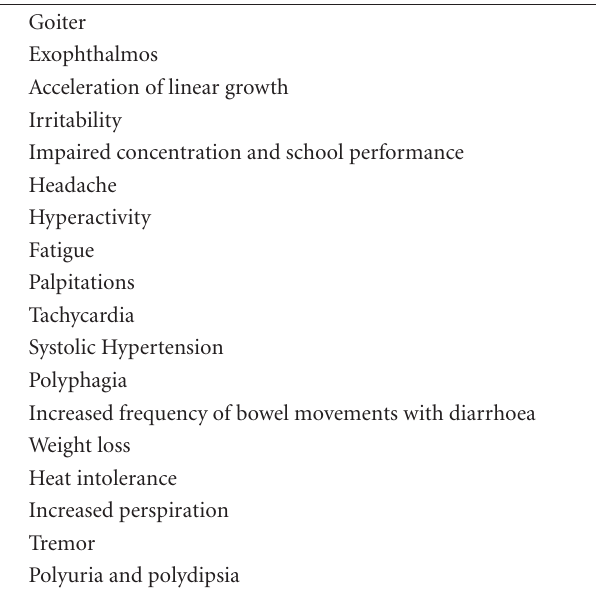
Table 4: Clinical signs and symptoms of hyperthyroidism in